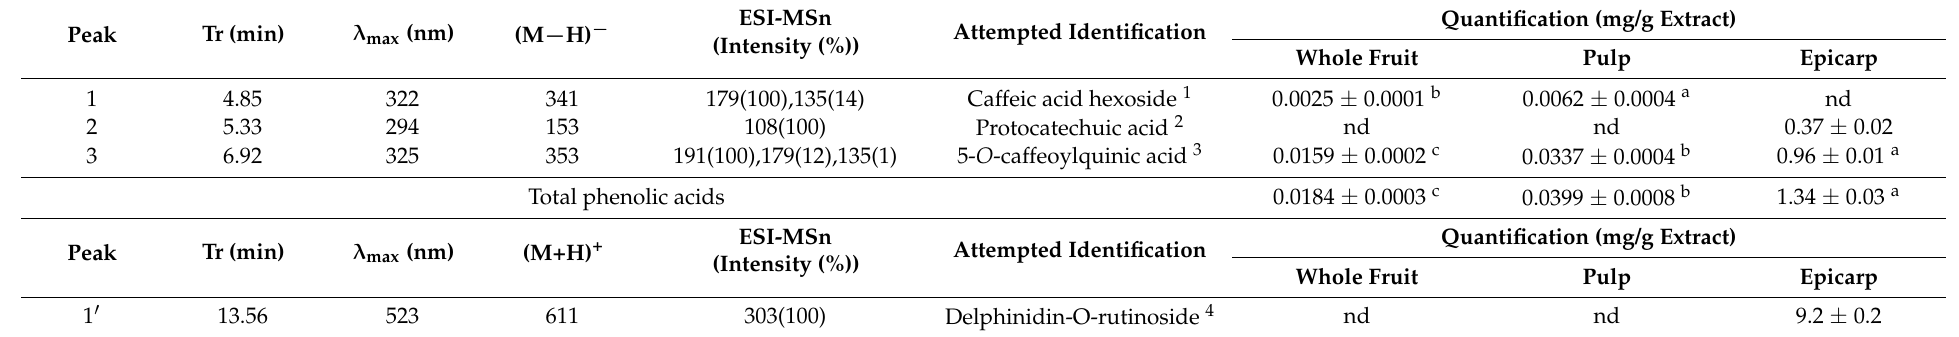
Table 5. Retention time (Tr), maximum absorption wavelengths in the UV-Vis region ( λ max ), attempt to identify and quantify phenolic compounds in the hydroethanolic extract of the pulp, epicarp, and the whole fruit of Solanum melongena L. (mean ±